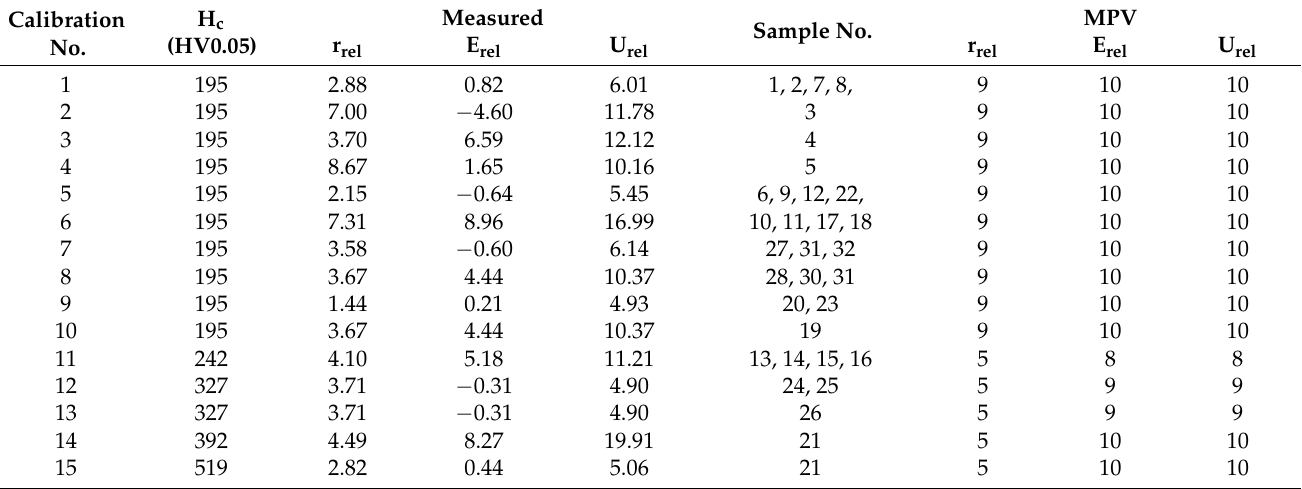
Table 2. Calibrations of the tester: specified hardness H c (HV0.05) of used CRM, measured results of calibration (r rel , E rel , U rel ), samples measured after calibration (the numbers are according to Table 1), and maximal permissible values (MPV) of the parameters, obtained by calibration, which was carried out under the standard ISO 6507-2